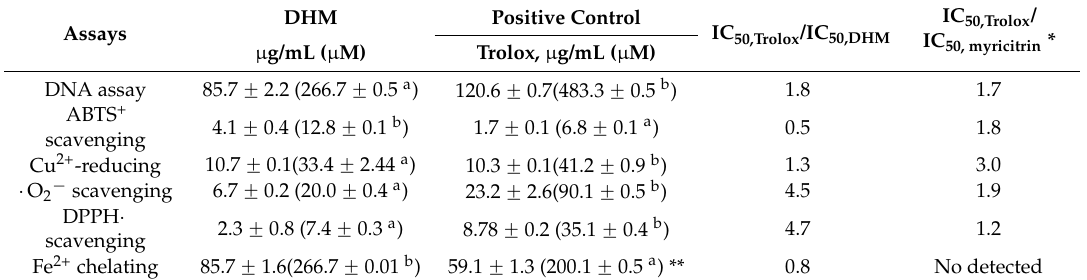
Table 1. The IC 50 values of dihydromyricetin (DHM) and Trolox in various assays. Assays